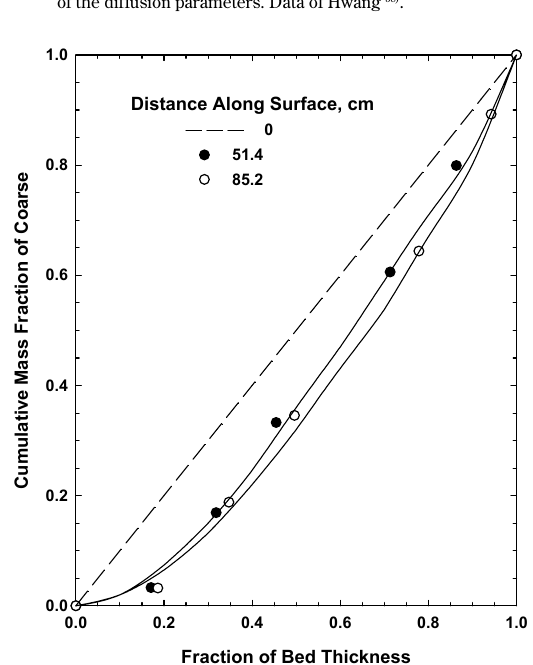
Fig. 7 Segregation of coarse (20 × 30 US mesh) and fine (50 × 70 US mesh) sand particles during flow of an initially homogeneous mixture over a rough surface. Data of Hwang 58)